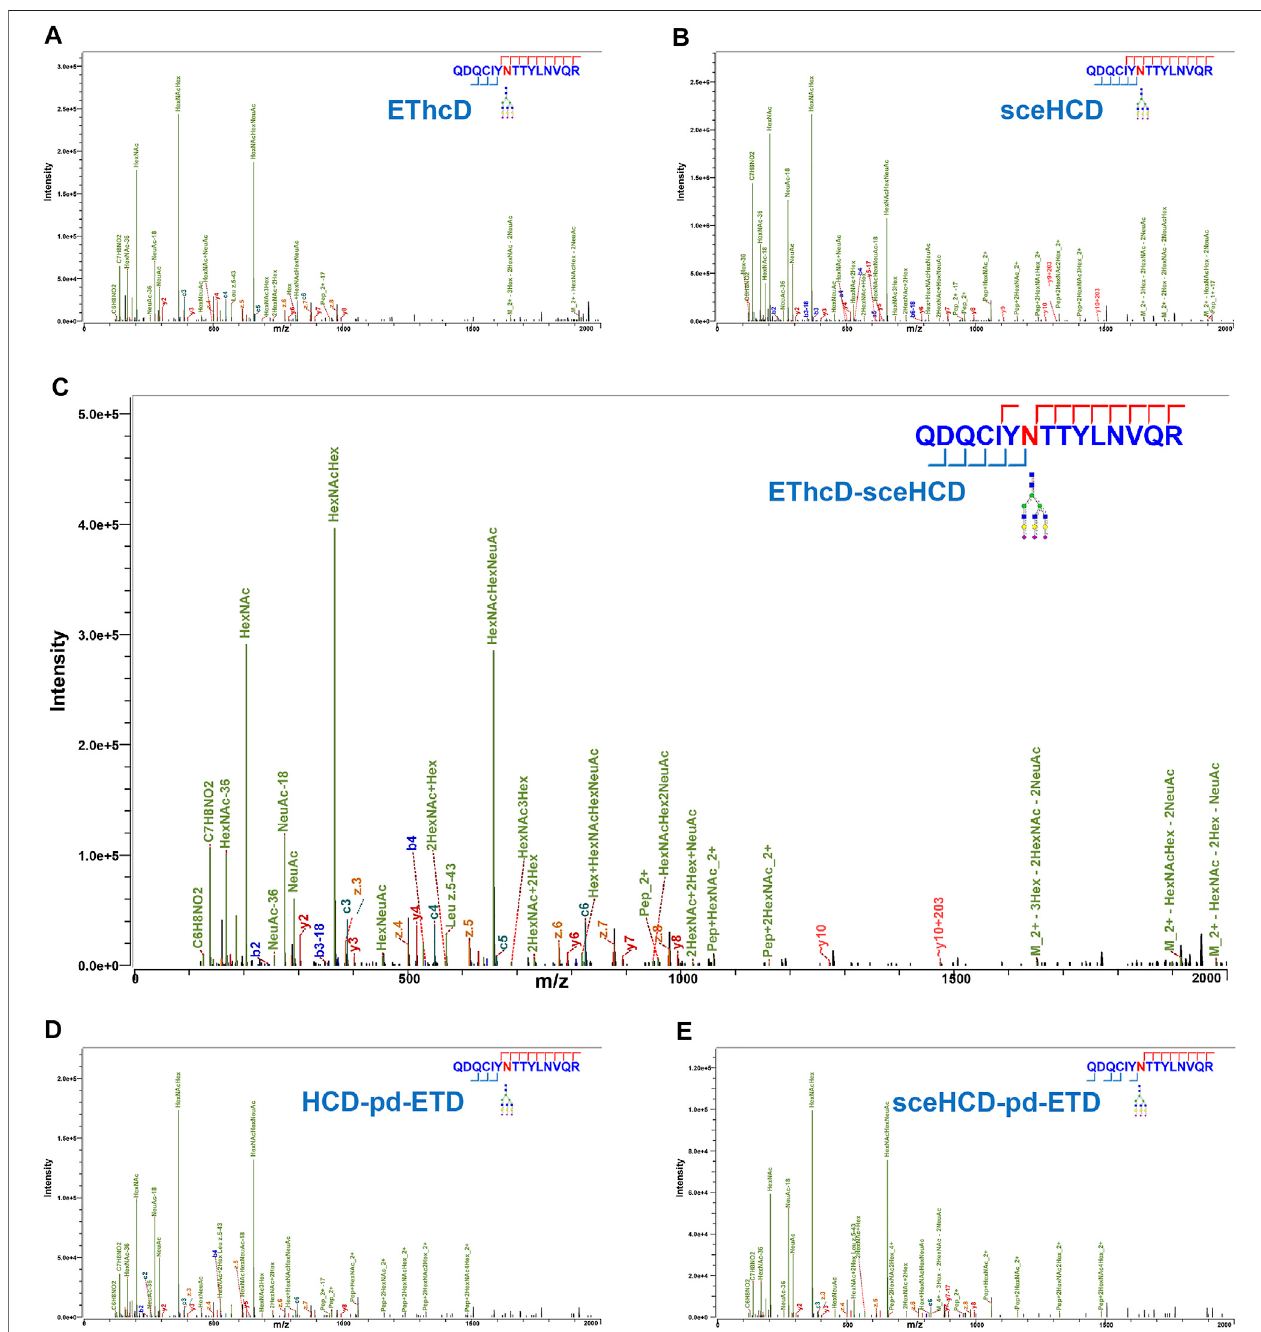
FIGURE 2 | Comparison of electron-transfer/higher-energy collisional dissociation (EThcD), stepped collision energy/higher-energy collisional dissociation (sceHCD), EThcD-sceHCD, higher-energy collisional dissociation-product-dependent electron-transfer dissociation (HCD-pd-ETD), and sceHCD-pd-ETD spectra of alpha-1-acid glycoprotein 1 N-linked glycopeptide (N93) from human plasma.